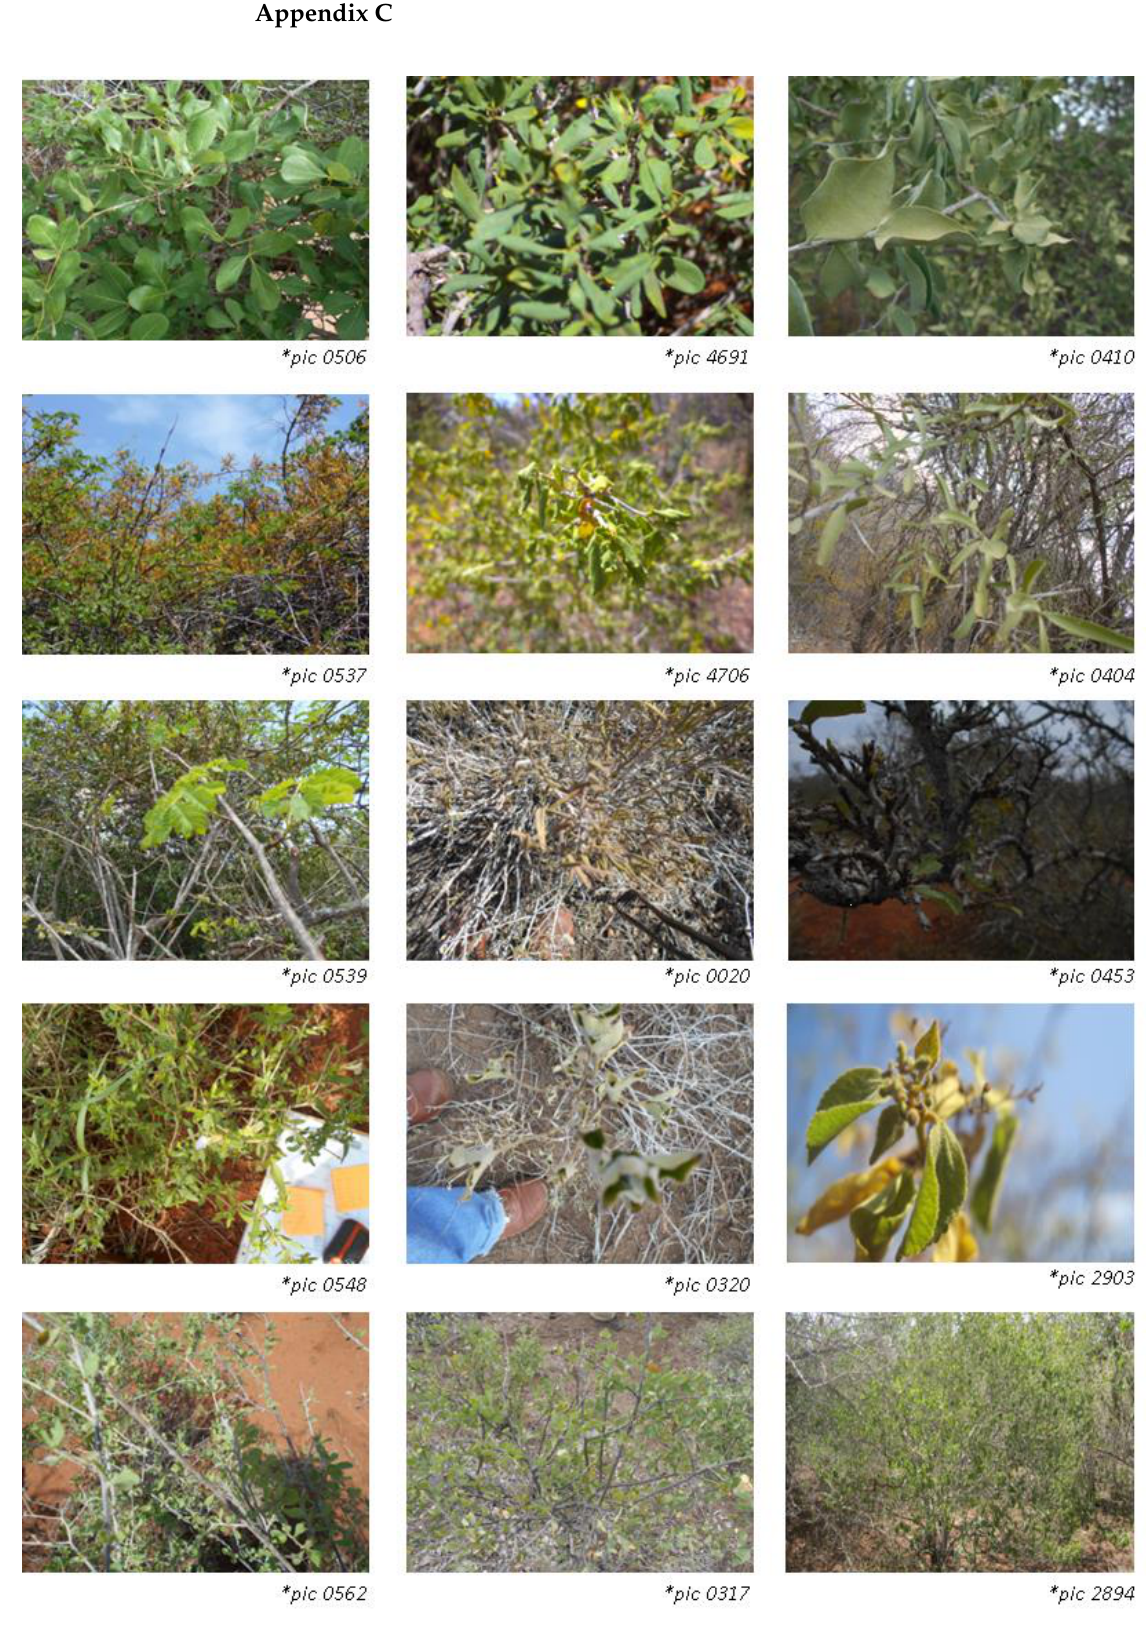
Figure A1. Unidentified/unverified vegetation species by the end of this study.